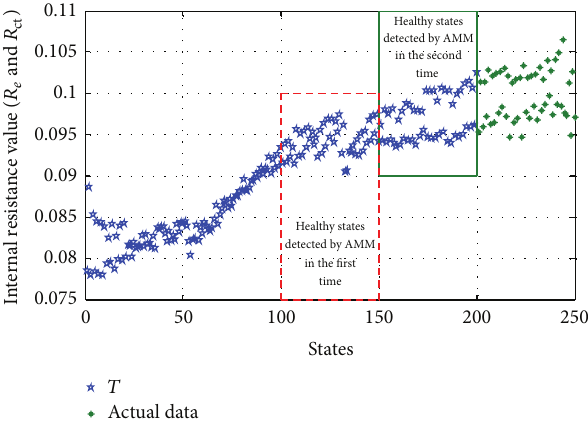
Figure 5: Update of training data 𝑇 with nonquantitative update